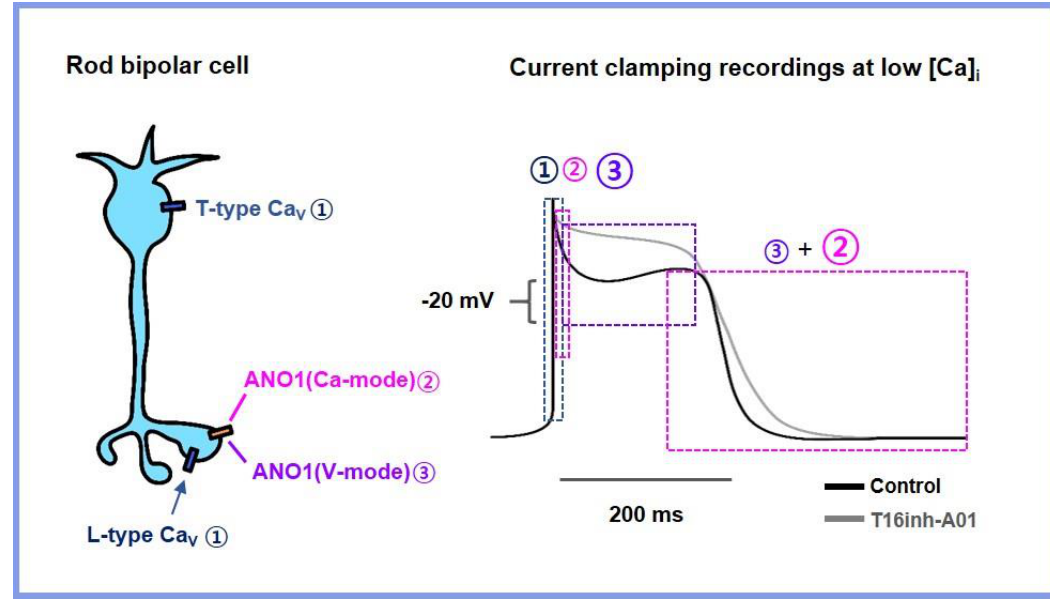
Figure 4. The dual gating mode of ANO1 in rod bipolar cells. (1) Voltage-gated Ca 2+ influx acts as a trigger for the (2) activation of voltage-dependent ANO1, which contributes to the rapid repolarization of the cell membrane potential and has outward rectifying properties at voltages above −20 mV. (3) At lower voltage conditions, only the slow-running Ca 2+ mode is ready to open, which may last longer when there is sufficient intracellular Ca 2+.